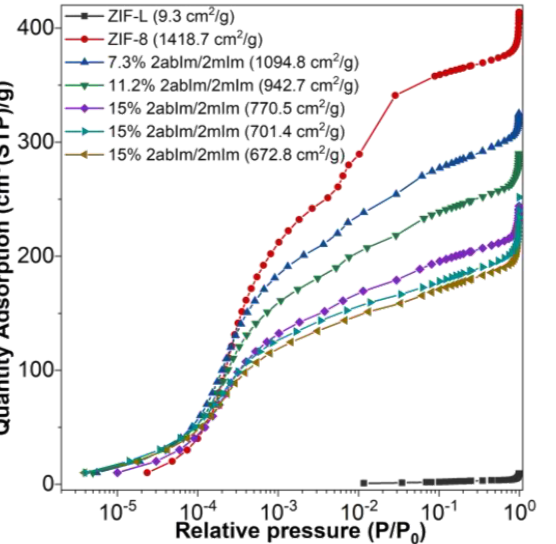
Figure 4. ( a ) SEM image of ZIF-L upon exposure to 0.1 M 2abIm containing 2:1 ( v / v ) DMAc/H 2 O solution for 8 h at 373 K, ( b ) XRD patterns of ZIF-L before and after exposure to 0.1 M 2abIm con- taining 2:1 ( v / v ) DMAc/H 2 O solution for 8 h at 373 K, ( c ) ATR-FTIR on 0.1 M, and 0.5 M of 2abIm treated ZIF-8 crystals, ( d ) composition analysis curves of 2abIm-treated ZIF-8 crystals obtained by solution 1 H-NMR.